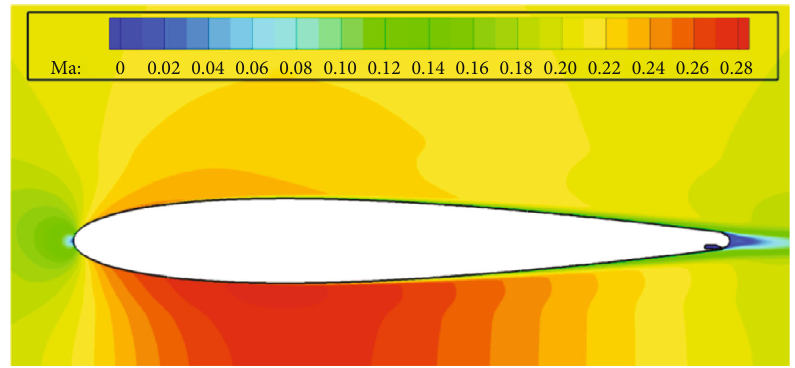
Figure 11: Mach number contours for airfoil without blowing at h / c = 0 : 2 and α = 0 ° .